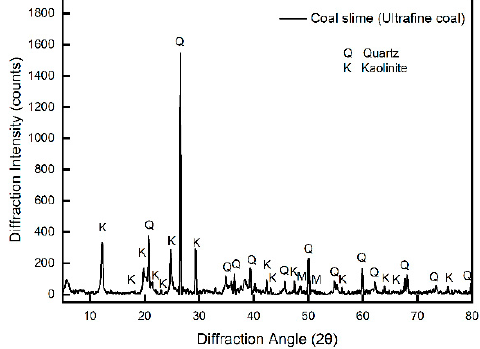
Figure 1. XRD result of coal slime (ultrafine coal).